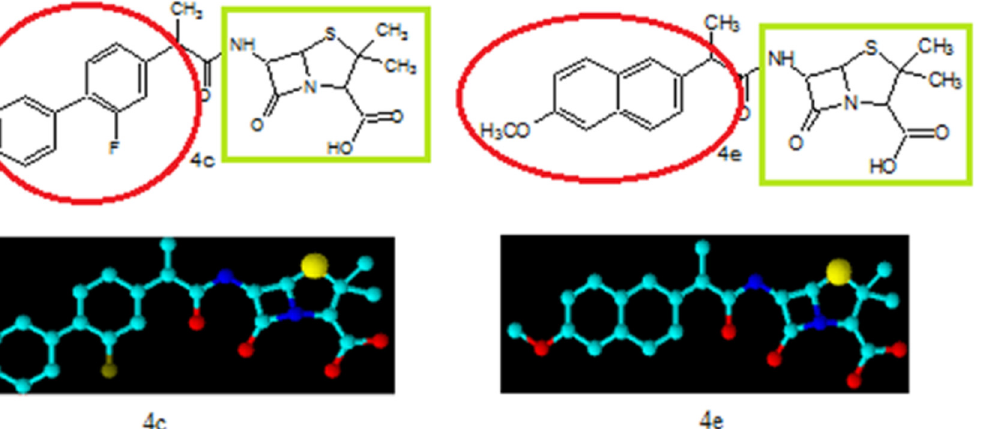
Fig 2. Chemical structure and three dimensional view of compounds 4c and 4e with highlighted green show the main penicillin nucleus and red show the designed moiety to increase the bioactivity.